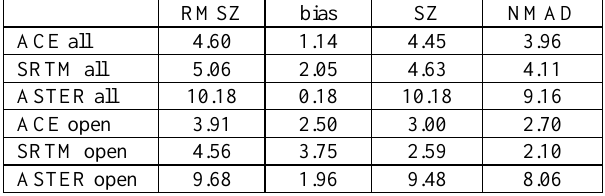
Table 1: accuracy in relation to reference data – for the